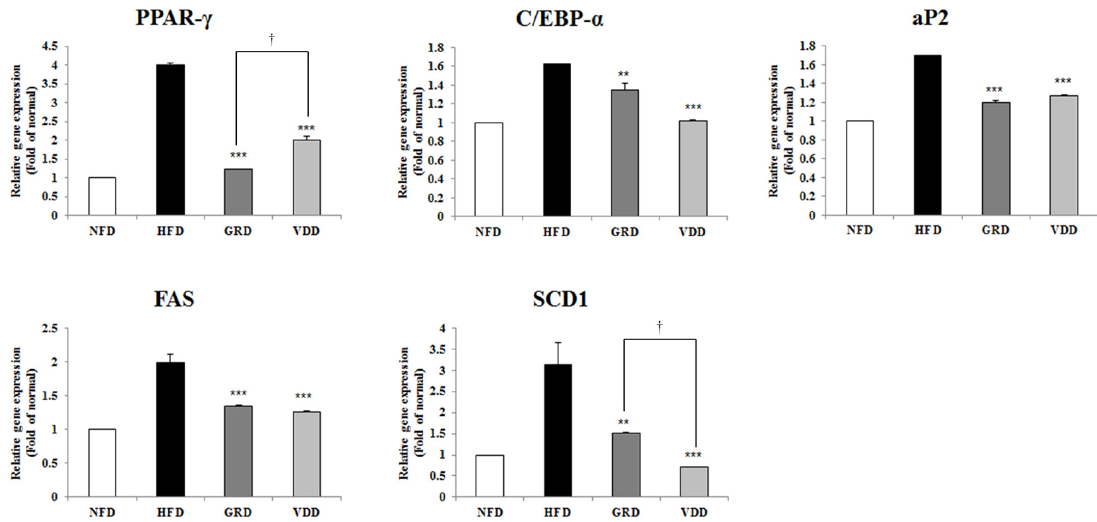
Figure 4. Effects of Valeriana dageletiana Nakai ex F. Maek extract from above-ground part (VDAE) on mRNA expression of adipogenic genes in epididymal white adipose tissue. Results are presented as means ± SE. The asterisk indicates a significant difference compared to HFD group (** p < 0.01, *** p < 0.001). The dagger indicates significant differences between GRD and VDD groups († p < 0.05). NFD; normal fat diet control, HFD; high fat diet control, GRD; HFD + 1% Garcina cambogia extract, VDD; HFD + 1% Valeriana dageletiana Nakai ex F. Maek extract from above-ground